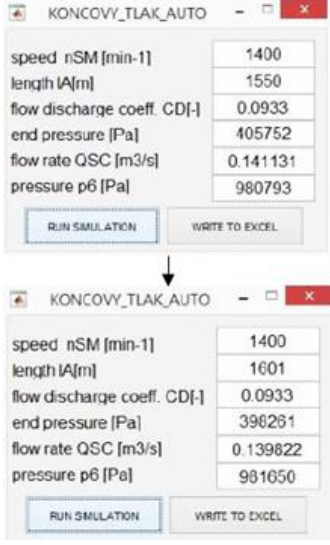
Fig. 5. Manual setting of slx file using MATLAB GUI .